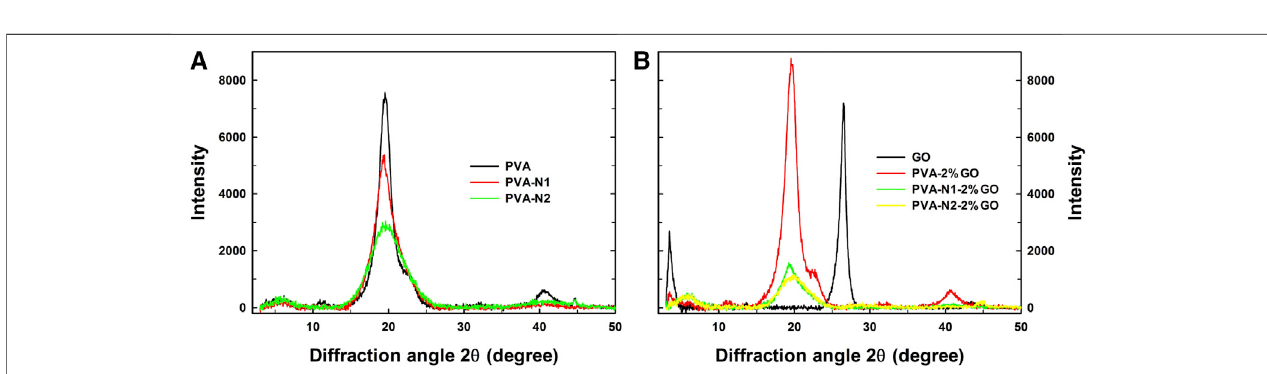
FIGURE 4 | XRD curves of PVA, PVA-N1, and PVA-N2 (A) , and their nanocomposites with 2 wt% GO (B) with the diffraction angle from 3 to 50 ° .